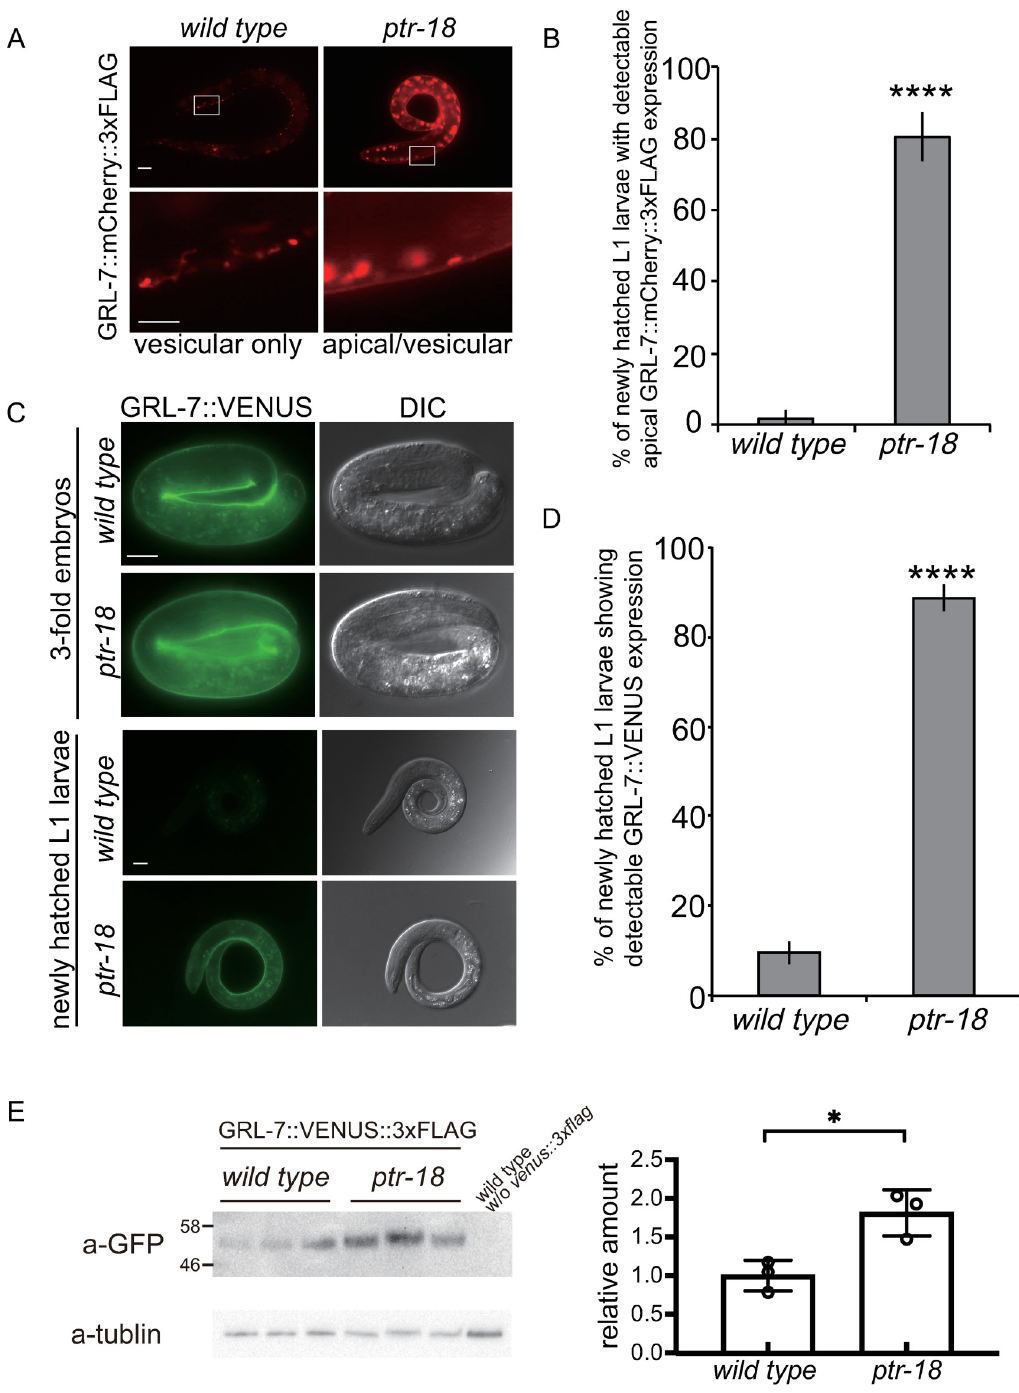
Fig 7. ptr-18 is required for the timely internalization of GRL-7. (A) Newly hatched wild-type and ptr-18 mutant L1 larvae showing vesicular (left) and apical/vesicular (right) distribution of GRL-7::mCherry::3xFLAG, respectively. The bottom panels are magnified views of the area within the rectangle from the images above. Scale bars indicate 10 μ m (upper panel) and 1 μ m (bottom panel). Photographs were taken with the same exposure time. (B) Apical localization of GRL-7::mCherry::3xFLAG was detected in most of the starved ptr-18 mutant larvae. n � 50 animals were scored for each genotype. Data were collected after 24 h L1 starvation and are presented as mean ± SD. Experiments were repeated three times, and n � 50 animals were scored for each trial. ���� : p < 0.0001 (Fisher’s exact test). (C) Loss of ptr-18 blocks the sequestration of GRL-7::VENUS. Wild-type and ptr- 18 mutant 3-fold embryos and L1 larvae after 24 h L1 starvation are shown. Photographs were taken with the same